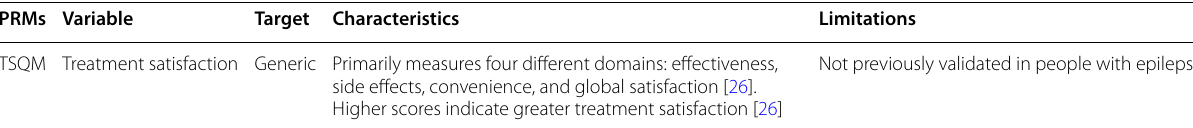
PREM Patient‑reported experience measure; ePREM Electronic patient‑reported experience measure. TSQM Treatment Satisfaction Questionnaire for Medication